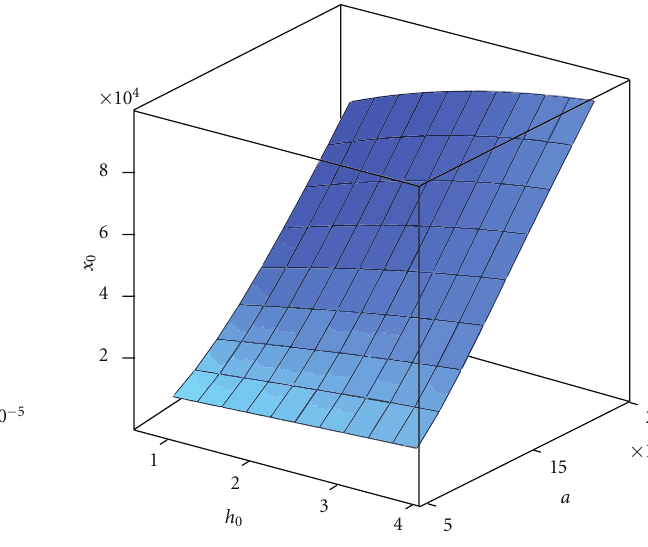
Figure 6: x 0 ( h 0 , m ) for a = 150000. Figure 7: x 0 ( h 0 , a ) for m = 2 × 10 − 5 .